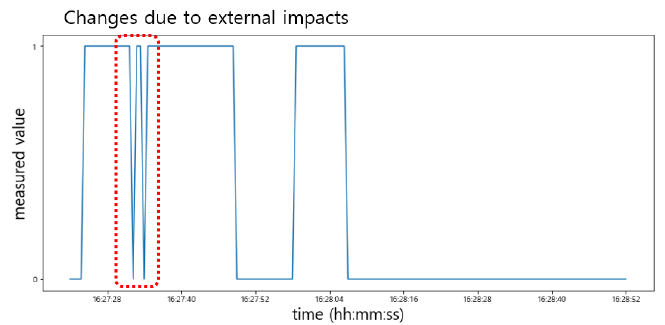
Figure 15. Changes in the sensed values due to the external impacts.